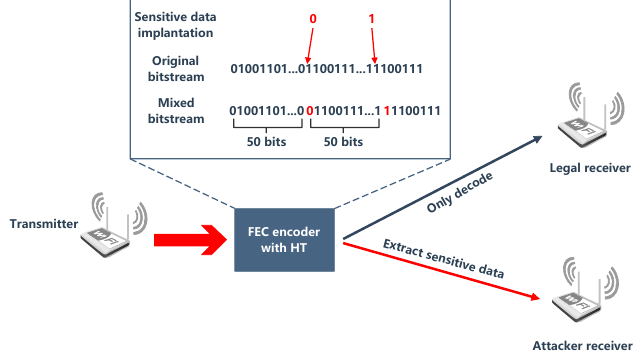
Figure 3. Threat model of forward error correction (FEC)-based Hardware Trojan (HT) in the wireless